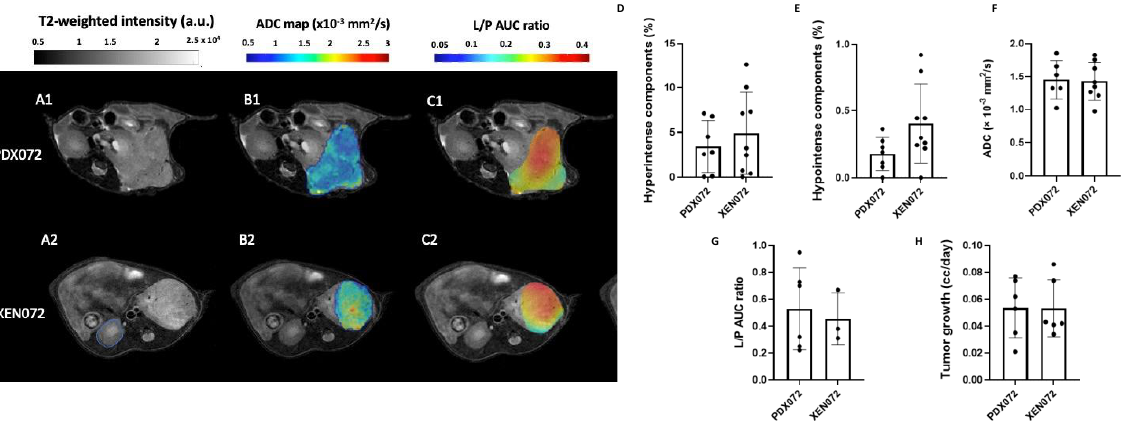
Figure 3. Comparison of features of PDX054 and XEN054. Panel on left: ( A1 , A2 ) Representative T2- weighted MR images of PDX and XEN implanted under the murine renal capsule. Red lines were drawn along the borders of the tumors. ( B1 , B2 ) Representative ADC maps overlaid on the T2- weighted images of PDX and XEN tumors. ( C1 , C2 ) Representative L/P AUC ratio maps overlaid on the T2-weighted images of PDX and XEN tumors. A.u.= arbitrary units; AUC = area under the curve. Bar graphs show: the % hyperintense ( D ) and % hypointense ( E ) components in all PDX and XEN tumors calculated from histograms of T2-weighted images; ( F ) ADC mean calculated for all PDX and XEN tumors; ( G ) the mean of the L/P AUC ratios for all PDX and XEN tumors; and ( H ) the tumor growth rate (cc/day). The significance of the one- way ANOVA with a Tukey’s multiple com- parisons test is indicated above the plots. All p < 0.05 indicated statistical significance.